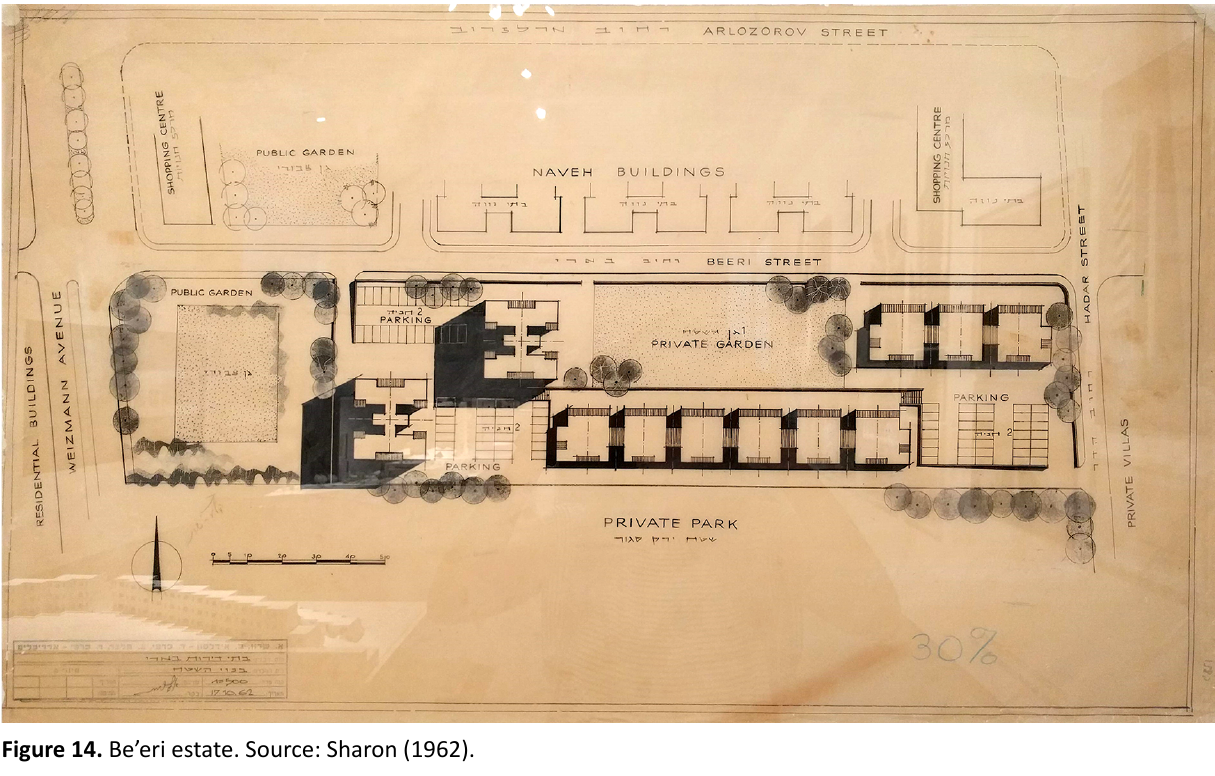
Figure 14. Be’eri estate. Source: Sharon (1962).